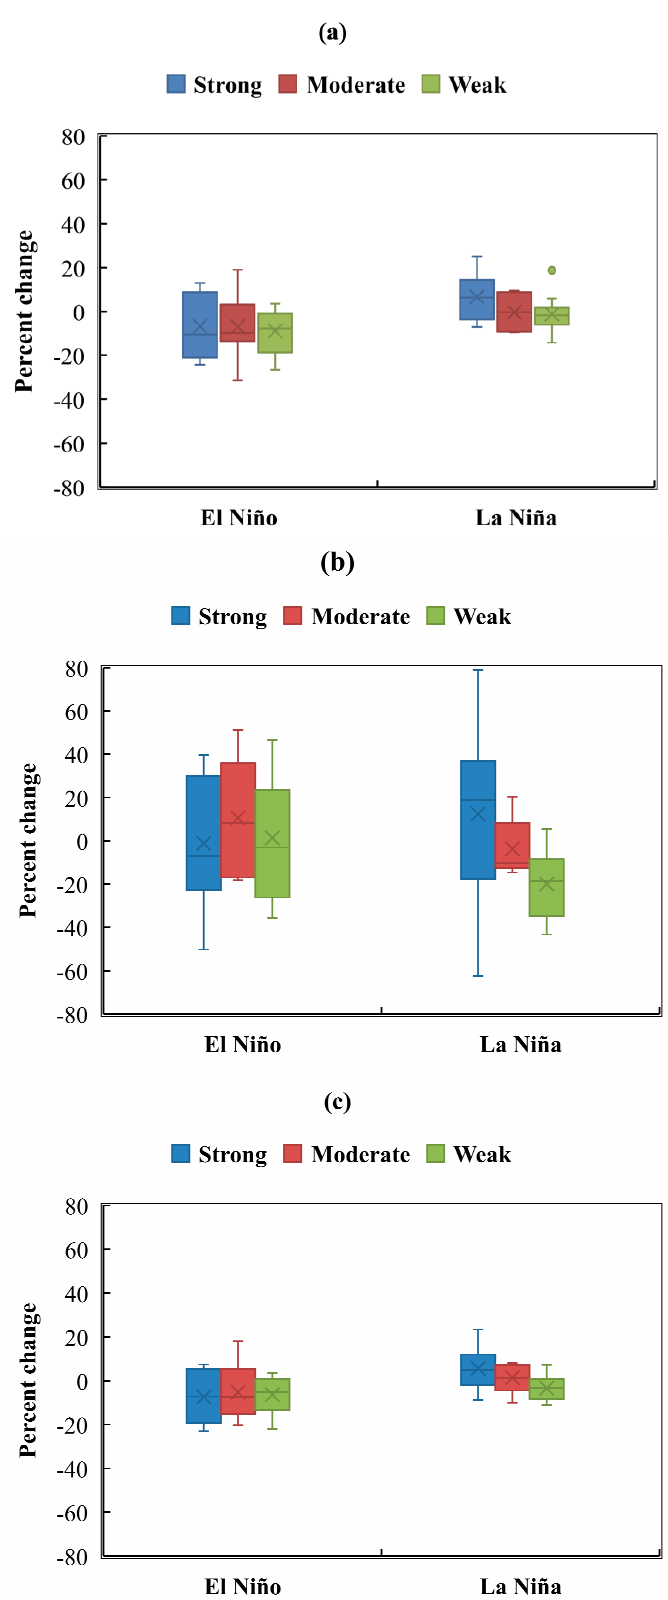
Figure 2. Box plots depicting the percent change in ( a ) S-W monsoon, ( b ) N-E monsoon, and ( c ) annual rainfall during El Niño and La Niña years compared to normal years in Karnataka (1951– 2014).